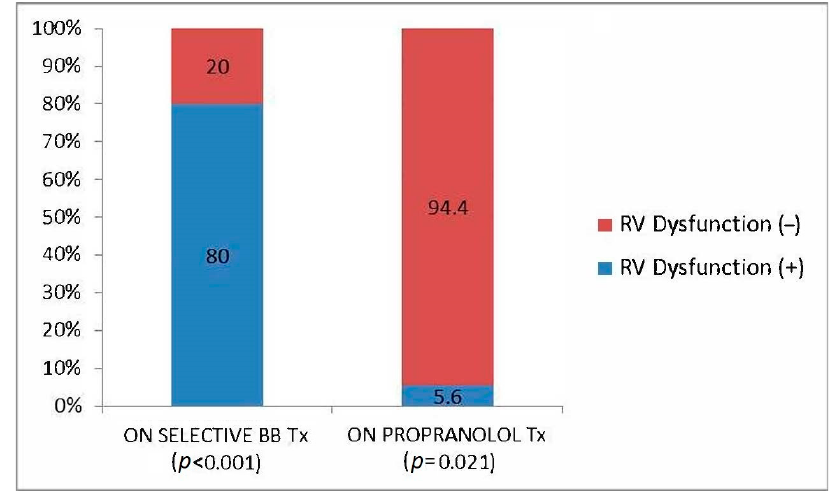
Figure 1. Relationship of non-selective beta blocker and isolated subclinical RVD.